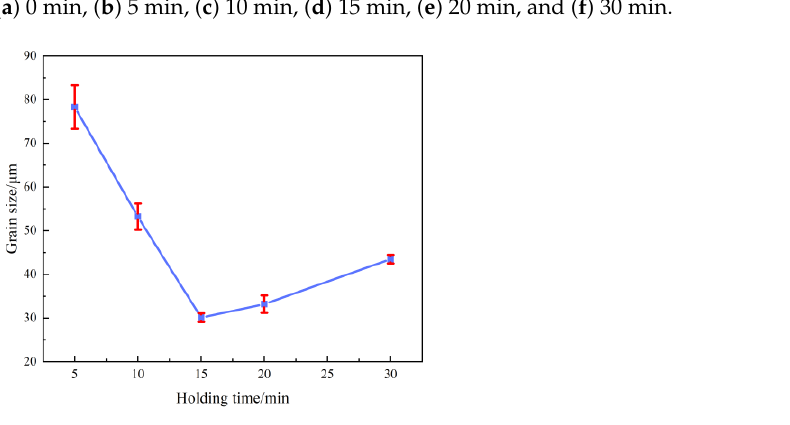
Figure 12. Variation of grain size of Graphite/AZ91D composites with different holding times.